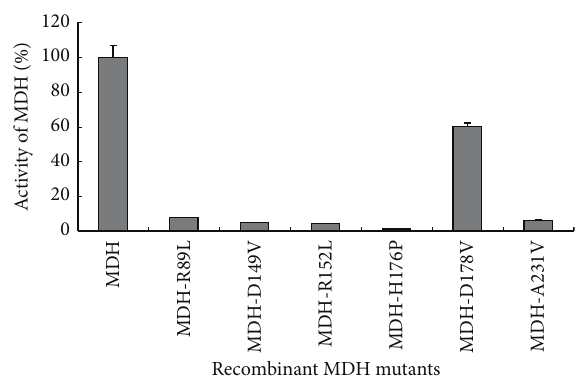
Figure 7: Enzymatic activity of the MDH mutant forms. The activities of the six mutant forms of the MDH were detected by measuring absorbance at 340 nm for the reduction of OAA at 1min intervals for 5 min at 40 ∘ C. The results showed that the substitutions of amino acids Arg 89, Asp 149, Arg 152, His 176, and Thr 231 almost abolished the activity of MDH. However, the mutant form with the substitutions of amino acids Asp178 kept 60% activities of the original MDH. The experiments were performed in